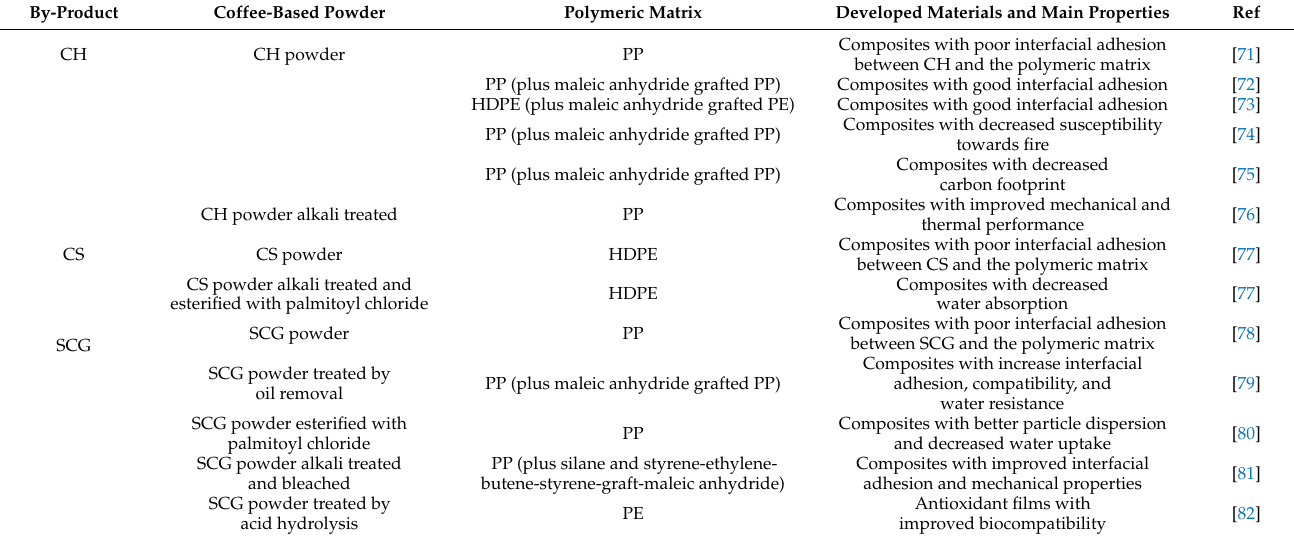
Table 2. Functional additives for nonbiodegradable plastic formulations using crude coffee by-products.